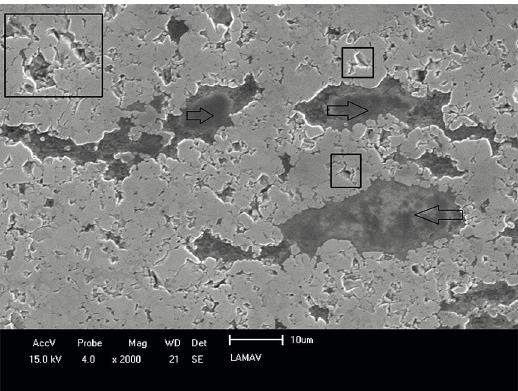
Figure 3. Structure of alloy REF. Pores (in squares) and elongated Co particles are shown.